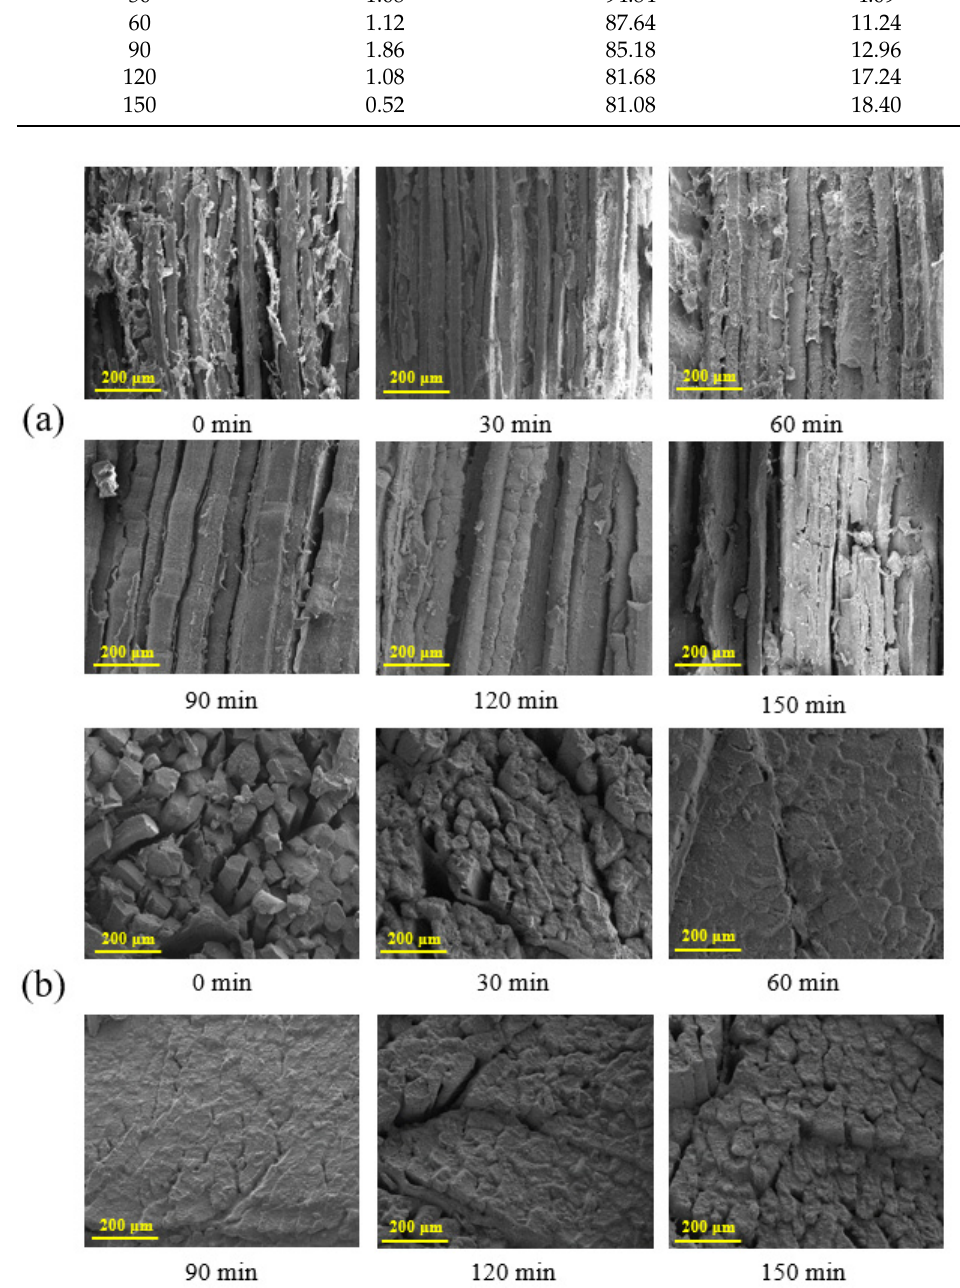
Figure 2. Analysis of Sichuan − style braised beef microstructure by SEM. ( a ) Longitudinal section, ( b ) cross − section.